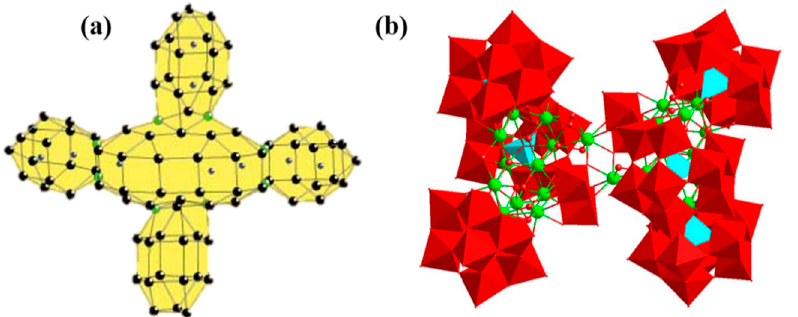
Figure 8. The ball-and-stick and polyhedral illustration of ( a ) (Ti 2 P 2 W 15 ) 2 (Ti 2 P 2 W 16 ) 2 (P 2 W 11 ) 2 polyoxoanion, ( b ) [Zr 24 O 22 (OH) 10 (H 2 O) 2 (W 2 O 10 H) 2 (GeW 9 O 34 ) 4 (GeW 8 O 31 ) 2 ] 32 − polyoxoanion. Color codes: WO 6 , red; GeO 4 , turquoise; Zr, bright green; O, red. Adapted with permission from ref. [86], copyright 2003 John Wiley and Sons.